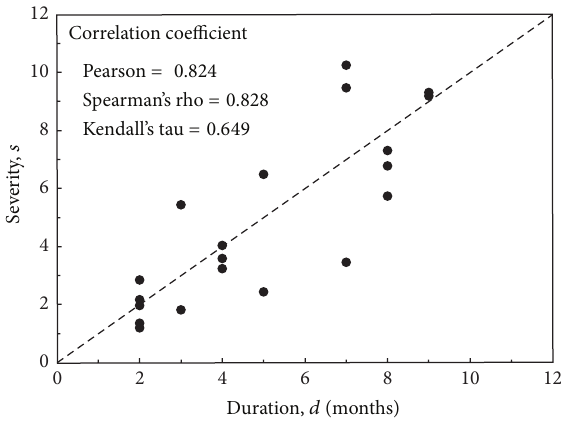
Figure 7: Drought severity versus duration for SPI3 series. The dashed line represents perfect